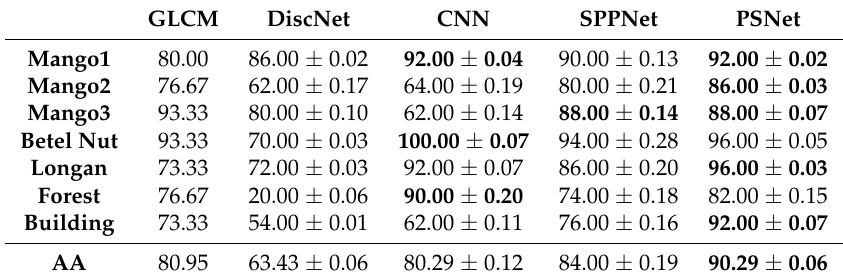
Table 5. Classification accuracy (%) on the Orchard dataset. The bold number highlights the greatest classification accuracy per row.